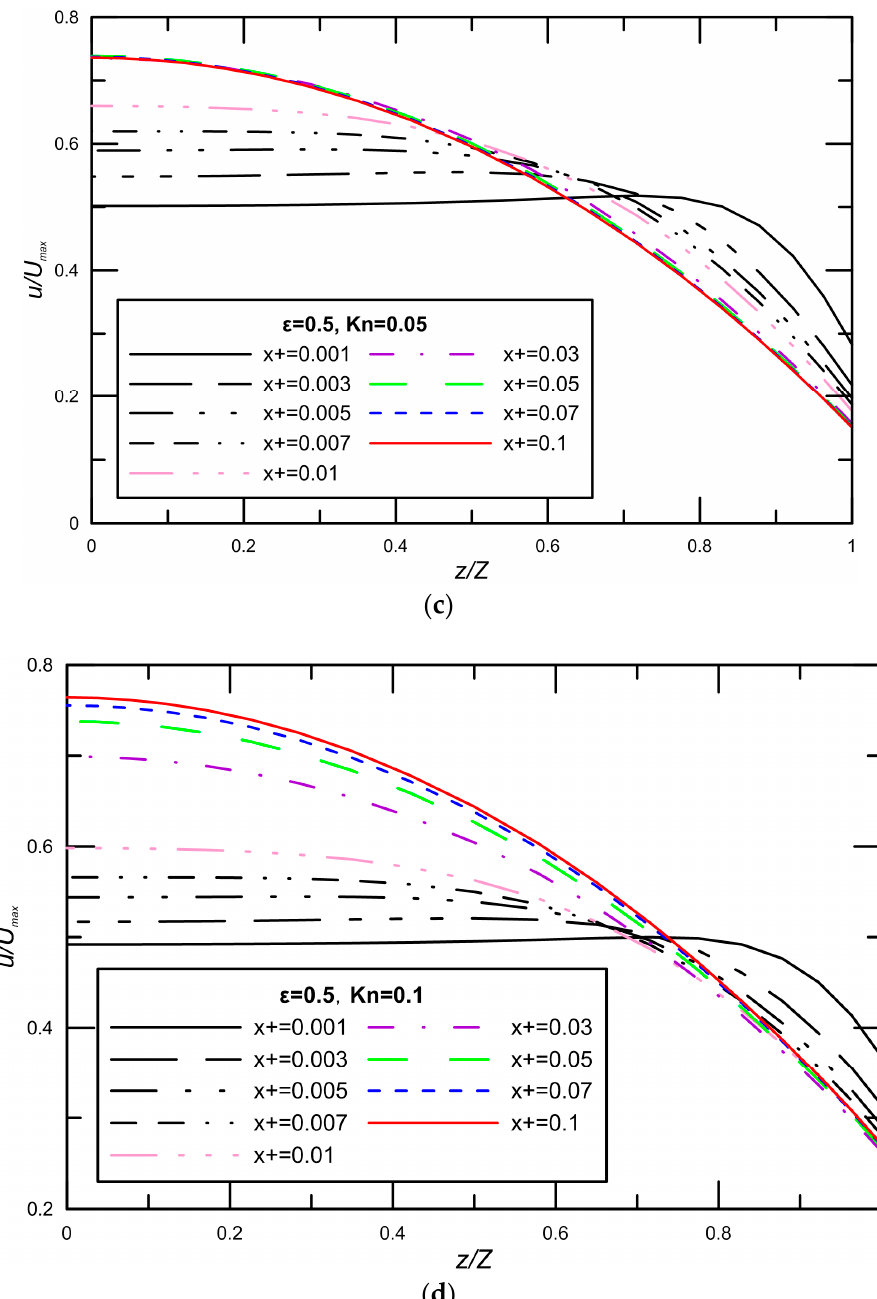
Figure 2. Developing velocity profiles in the streamwise direction of the microchannel in the slip regime.